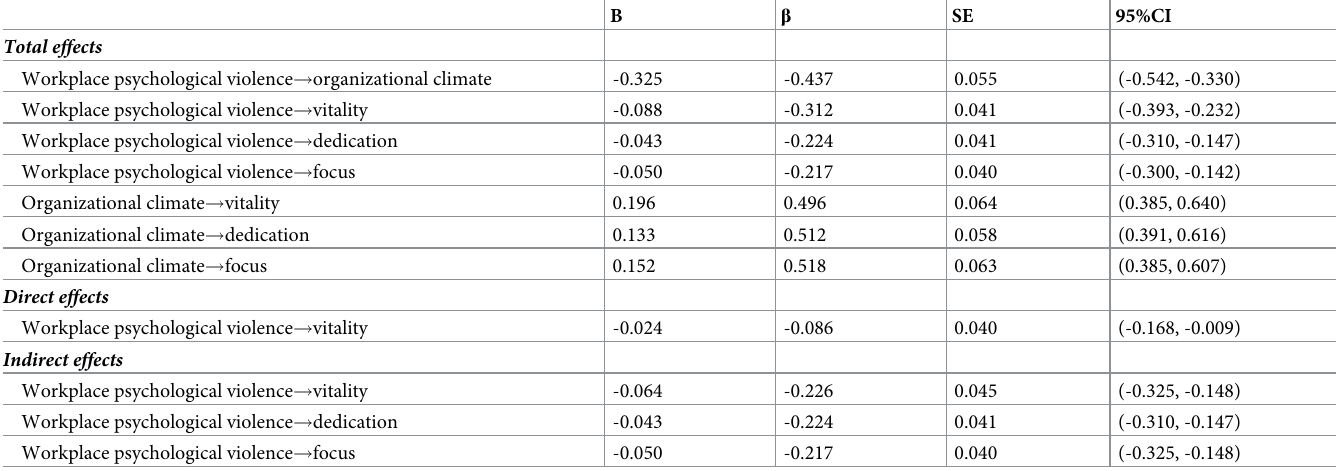
Table 4. Total effects, direct effects, and indirect effects of workplace psychological violence and organizational climate on work engagement. B β SE